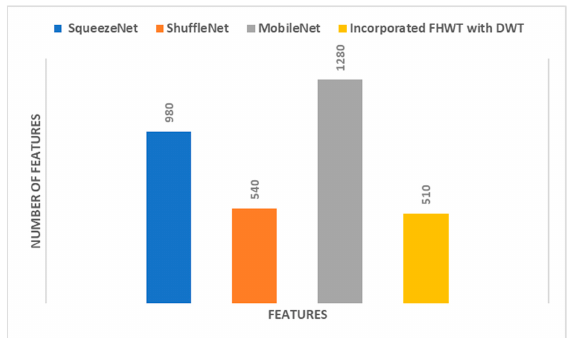
Figure 8. The number of features of each of the deep features extracted from the three CNN com- pared to the incorporated reduced features of FWHT used to train the four machine learning classi- fiers.